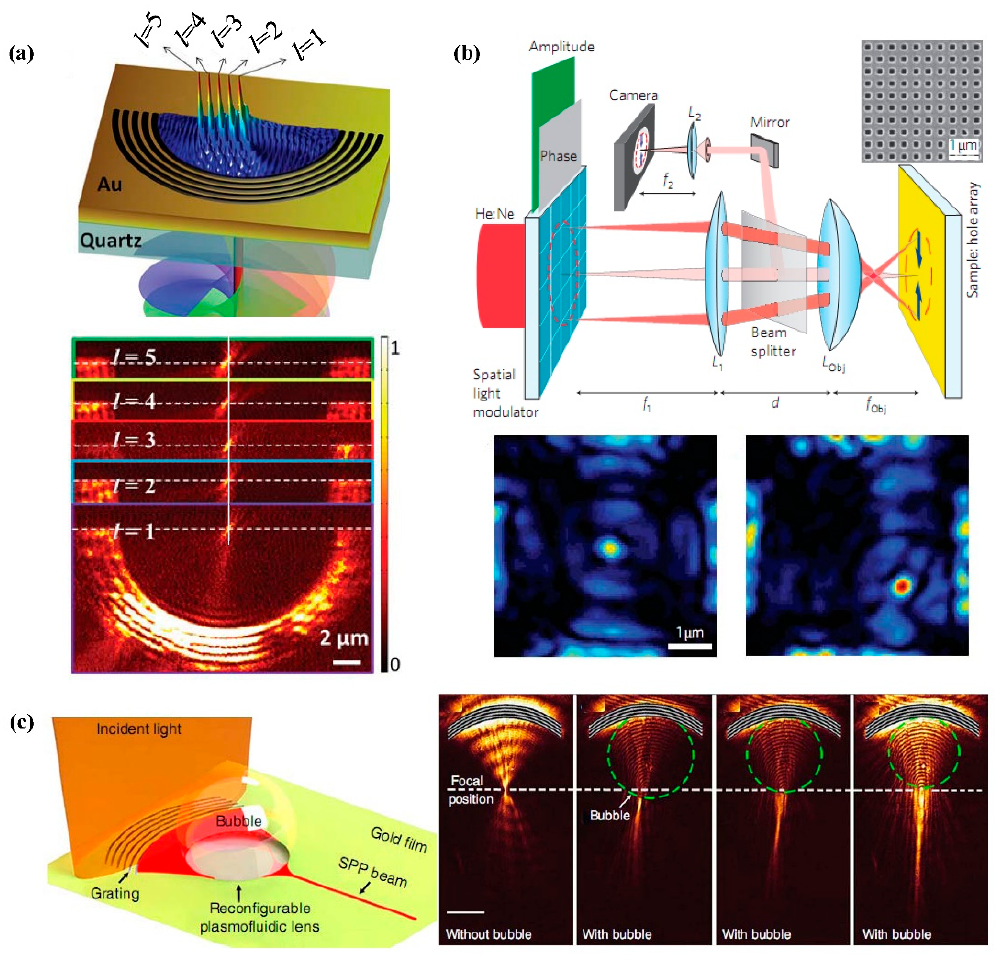
Figure 4. ( a ) Controlled focusing of SPP with vortex incident beam [83]; ( b ) Adjusting the SPP focus by modulating the phase and amplitude of the incident light with a spatial light modulator (SLM) [36]; ( c ) A dynamically tunable and reconfigurable SPP lens immersed in the water [92].